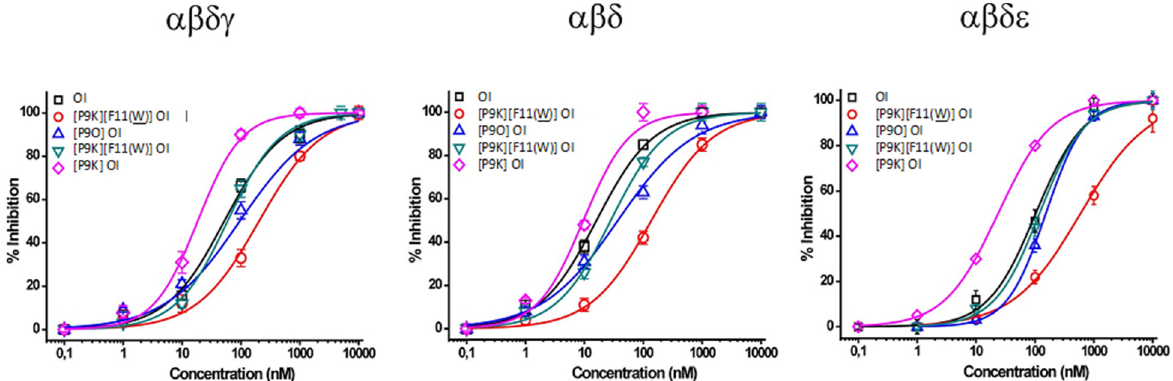
Figure 4. Percent inhibition of Xenopus laevis oocytes expressing nAChR isoforms: αβδγ , αβδ , and αβδ ϵ by α -conotoxin OI and analogs on a nanomolar scale.